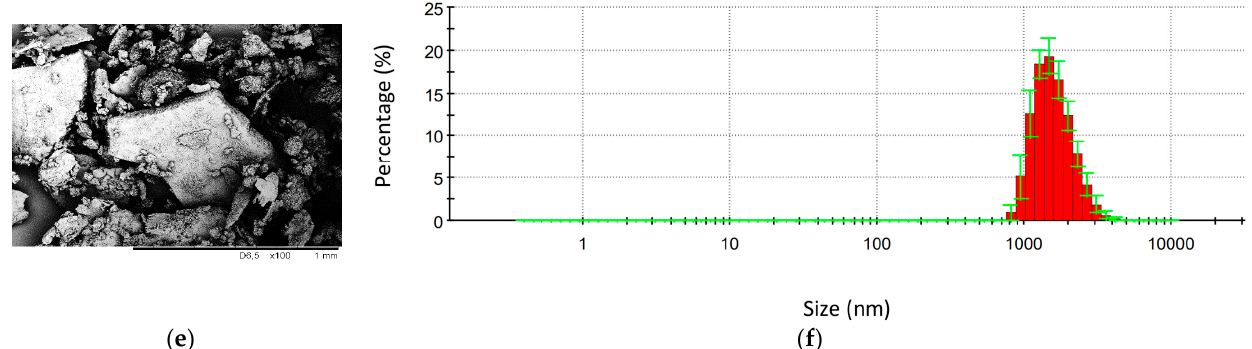
Figure 1. Topography and particle size distribution of ( a , b ) SC; ( c , d ) SC_S; and ( e , f ) SC_O.